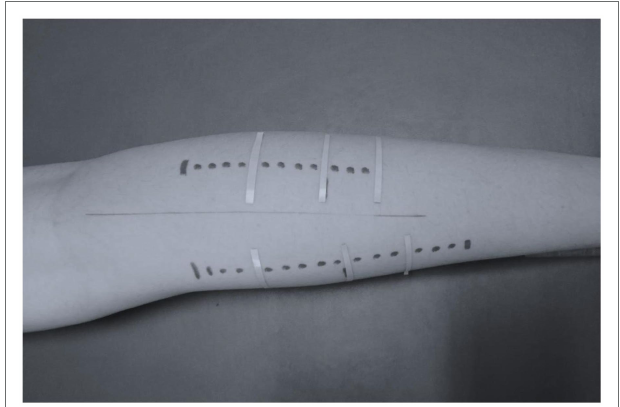
FIGURE 2 | Probe path for ultrasonography assessment of gastrocnemius medialis and lateralis.